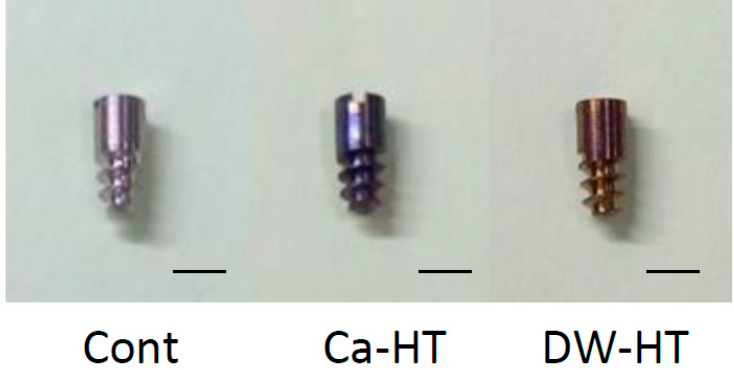
Figure 1. Experimental implants: titanium implant without any treatment (Control group: Cont), CaCl 2 -hydrothermally treated implant (Ca-HT) and distilled water-hydrothermally treated implant (DW-HT) (bar = 2 mm).